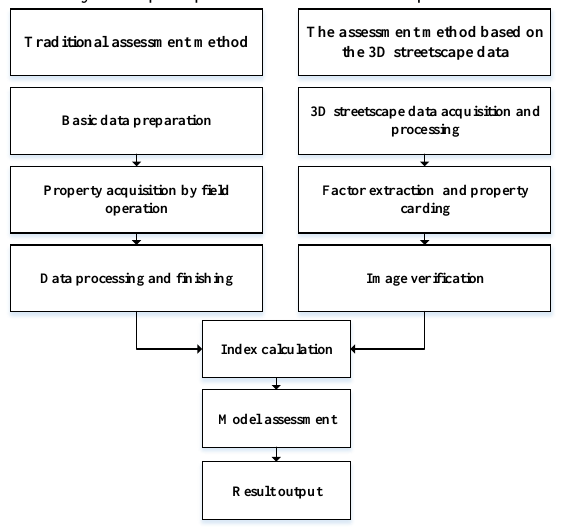
Figure 2. Urban regional assessment model based on